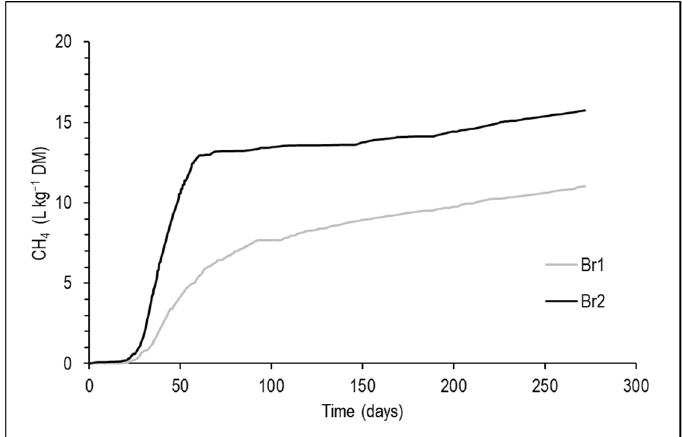
Figure 3. Cumulative CH 4 production.